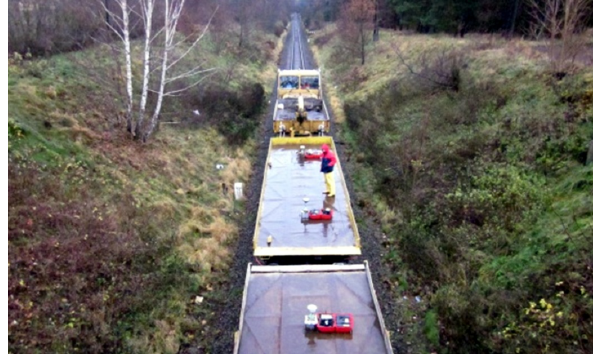
Figure 1: Configuration of GNSS receivers on the PWM-15